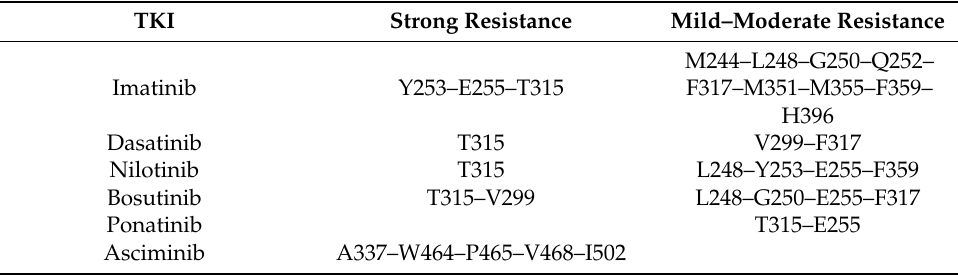
Table 1. Spectrum of BCR-ABL1 mutations, their localization, and their relationship with TKi. TKI Strong